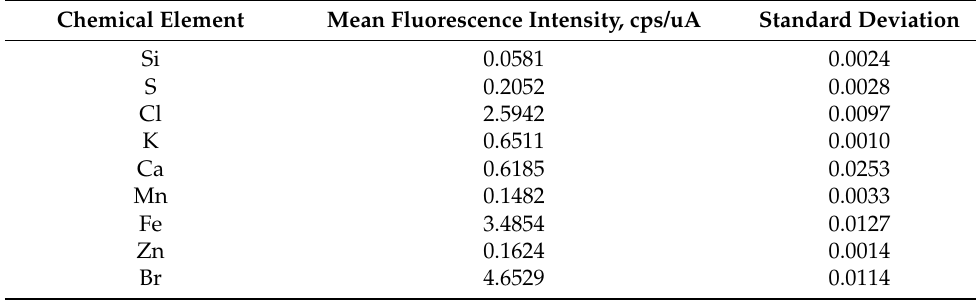
Table 6. Mineral composition of optimized ethanolic bark extract of Enantia chlorantha .